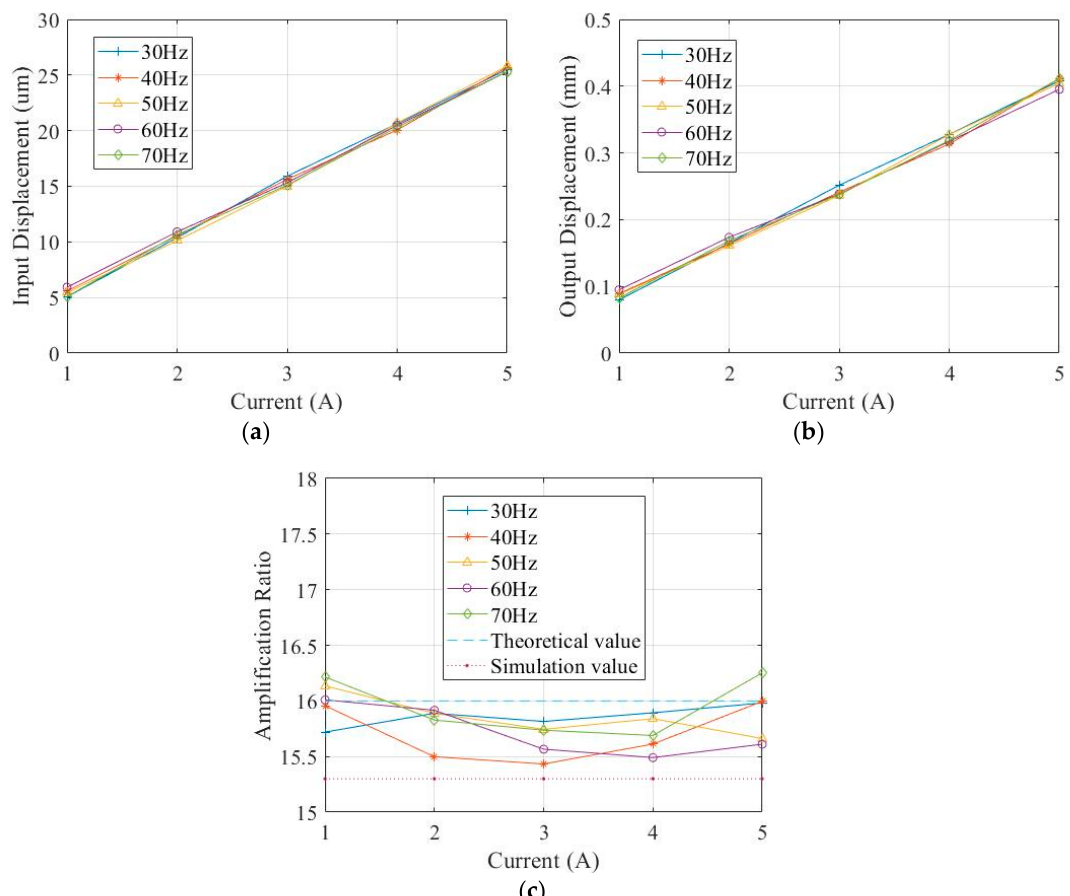
Figure 17. Response of sinusoidal excitation. ( a ) Input displacement & current, ( b ) Output displacement & current, ( c ) Amplification ratio & current.